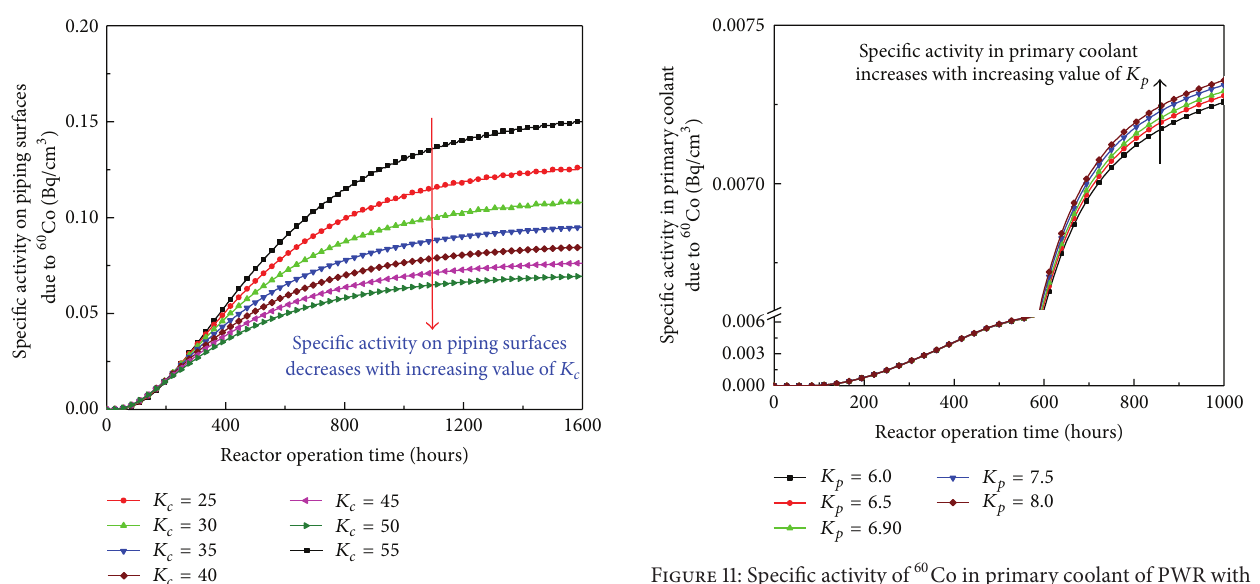
Figure 9: Specific activity of 60 Co on primary coolant piping surfaces of PWR with different values of 𝐾 𝑐 .